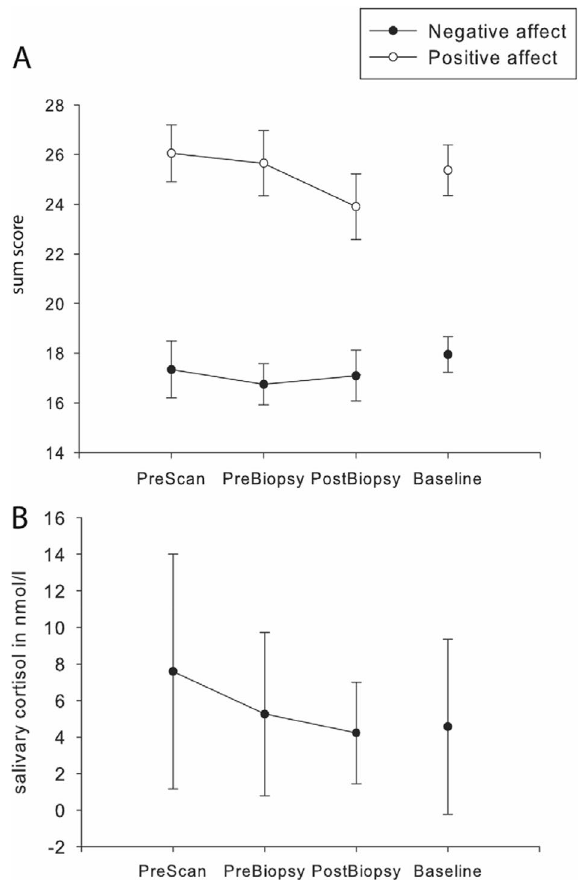
Figure 2. ( A ) Mean PANAS scores for positive and negative subjective ratings of current affective state at different stages of the procedures. Error bars indicate one standard deviation. ( B ) Mean salivary cortisol values measured at time-points of the biopsy. Error bars indicate one standard deviation.